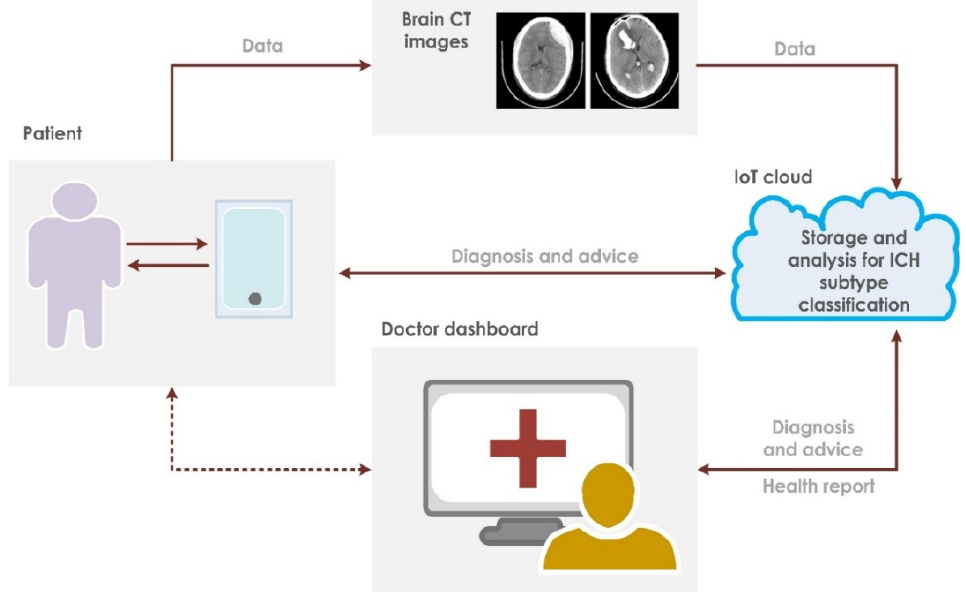
Figure 6. Proposed IoT-based architecture for ICH classification. Table 11. Performance comparison of different